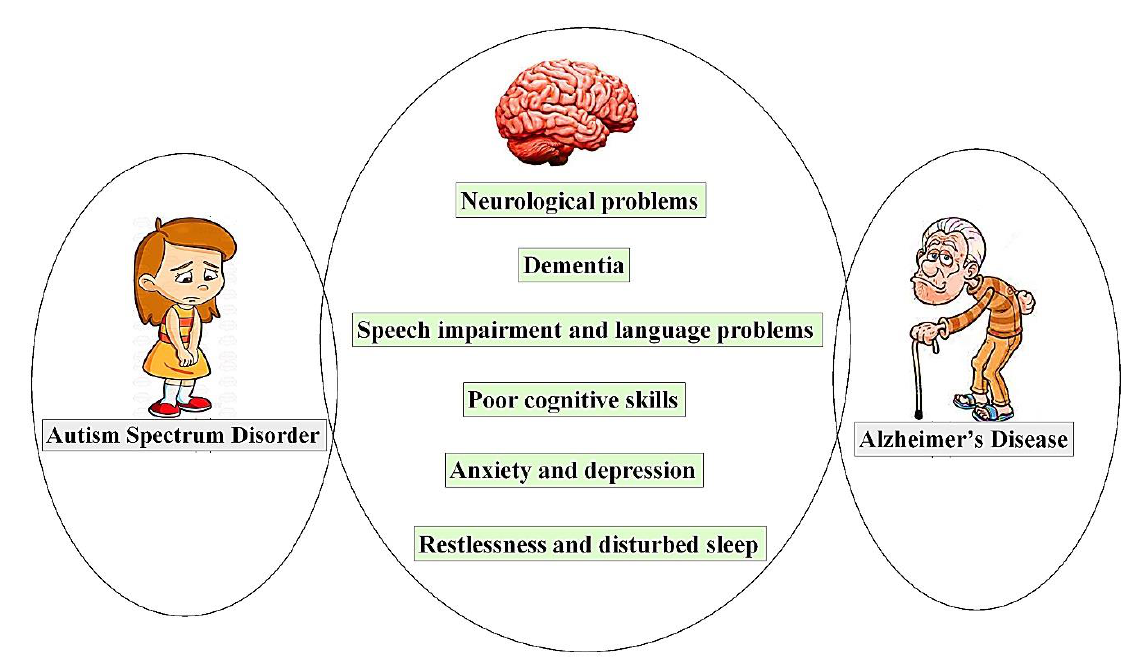
Figure 2. A brief illustration of correlated signs and symptoms representing autism spectrum disorder and Alzheimer’s disease.